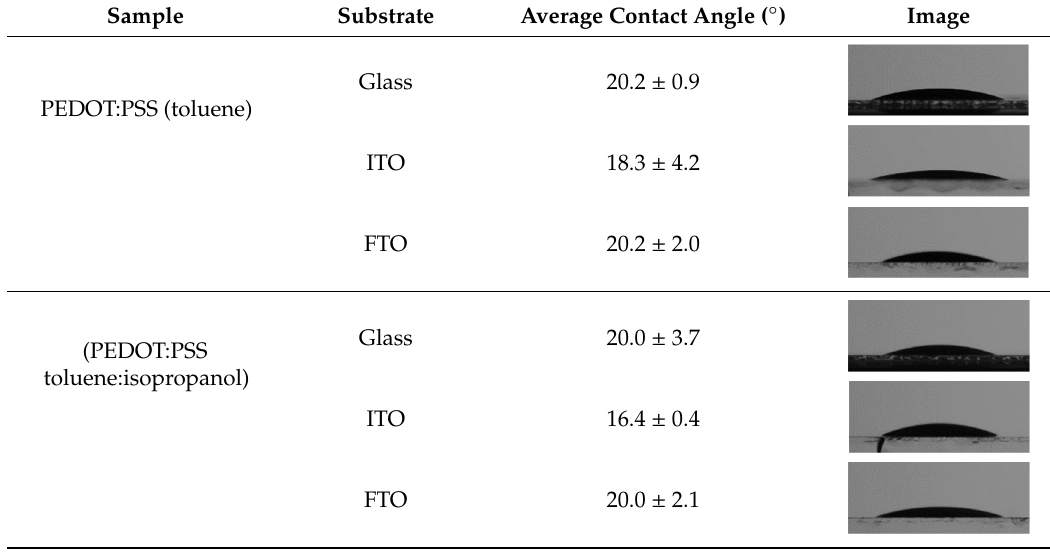
Table 2. Contact angle results for three different surfaces (glass, glass/ITO, and glass/FTO) for toluene-based PEDOT:PSS solutions with and without alcohol.